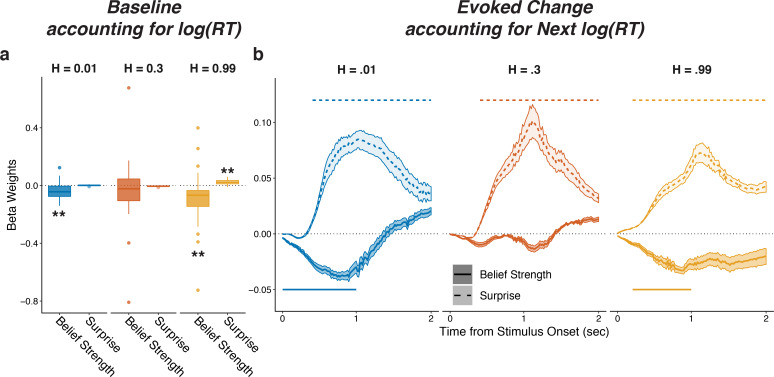
Pupils encode belief strength and surprise independently of RT.Linear mixed-effects beta weights estimating the influence of subject absolute belief strength and surprise on: (a) baseline pupil diameter, after accounting for log RT on the current trial and the previous evoked pupil change; and (b) evoked change, after accounting for log RT on the next trial and baseline pupil on the current trial and baseline pupil and evoked from the previous trial. In a, solid horizontal lines, hinges, whiskers, and points correspond to median, interquartile range, interquartile x 1.5, and outliers, respectively; **: p<0.01, ***: p<0.001. In b, lines and shading correspond to mean ± SEM across subjects, and straight lines above (for positive betas) and below (for negative betas) beta values indicate significant timepoints (FWE corrected p<0.05).